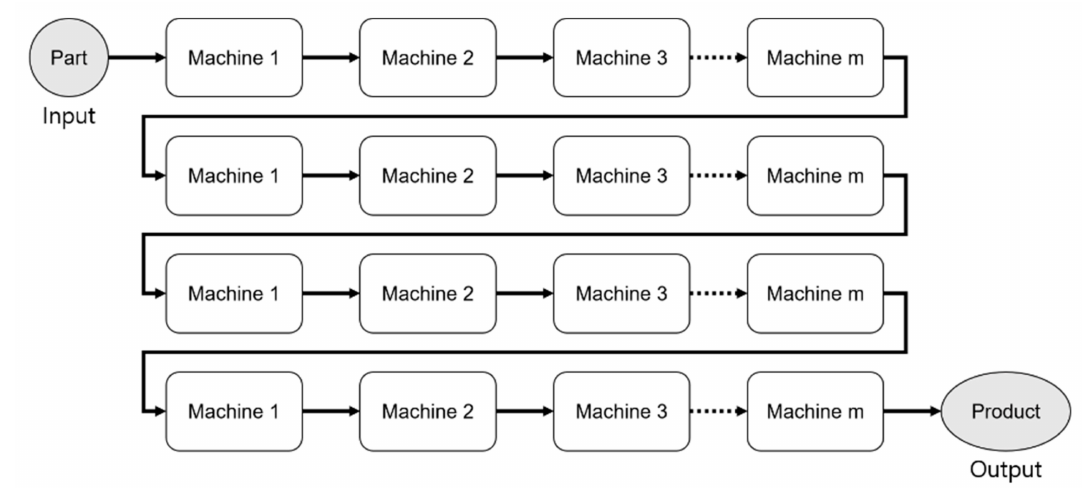
Figure 1. Re-entrant production line